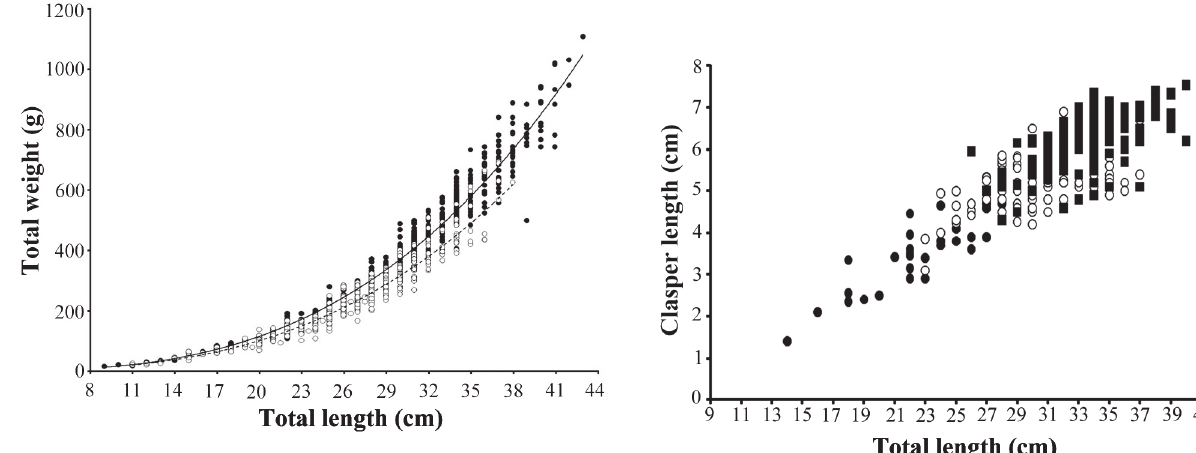
Fig. 5. Relationship between total length (TL) and total weight (TW) for Discopyge tschudii . Males (  ): TW(continuous line)= 0.02 X LT 2.899 ; R 2 = 0.97; n= 556. Females ( o ): TW(dotted line)= 0.021 X LT 2.835 ; R 2 = 0.97; n= 480.